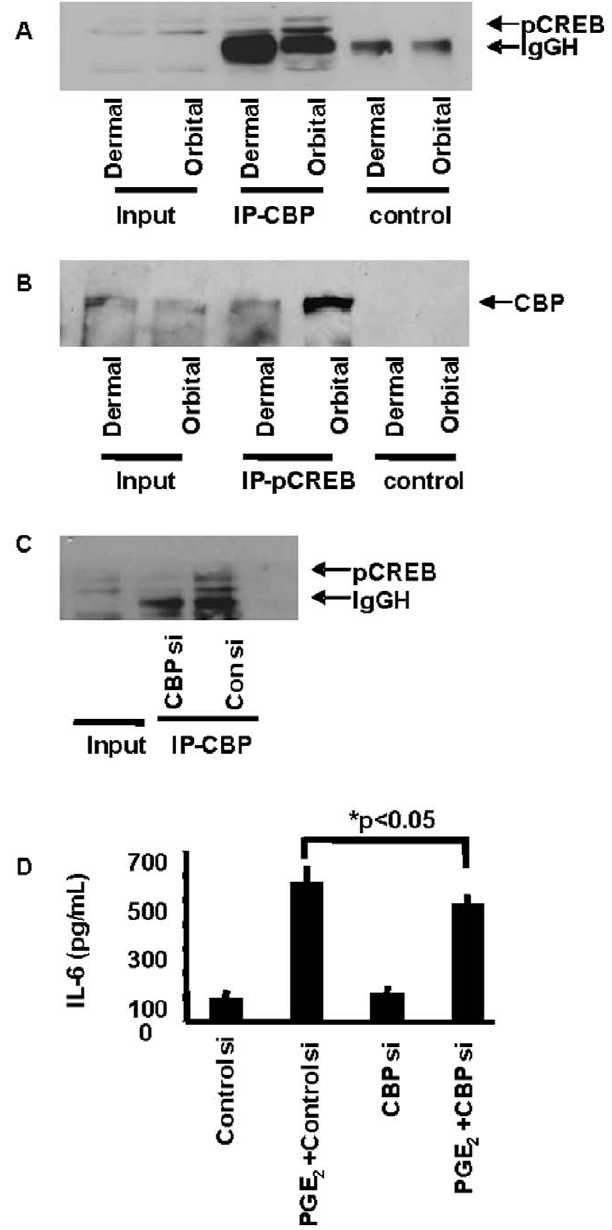
Figure 8. Divergent CBP/pCREB complex formation and its importance to PGE 2 -dependent IL-6 expression in orbital fibroblasts. A : Pull-down studies demonstrating CBP/pCREB protein- protein interactions provoked by PGE 2 . Representative Western blot demonstrates pCREB protein (arrow) in nuclear extracts from one dermal and one orbital fibroblasts (input), or following immunoprecip- itation with either anti-CBP antibody (IP-CBP) or a control antibody (control). B : Western blot demonstrating CBP protein (arrow) in